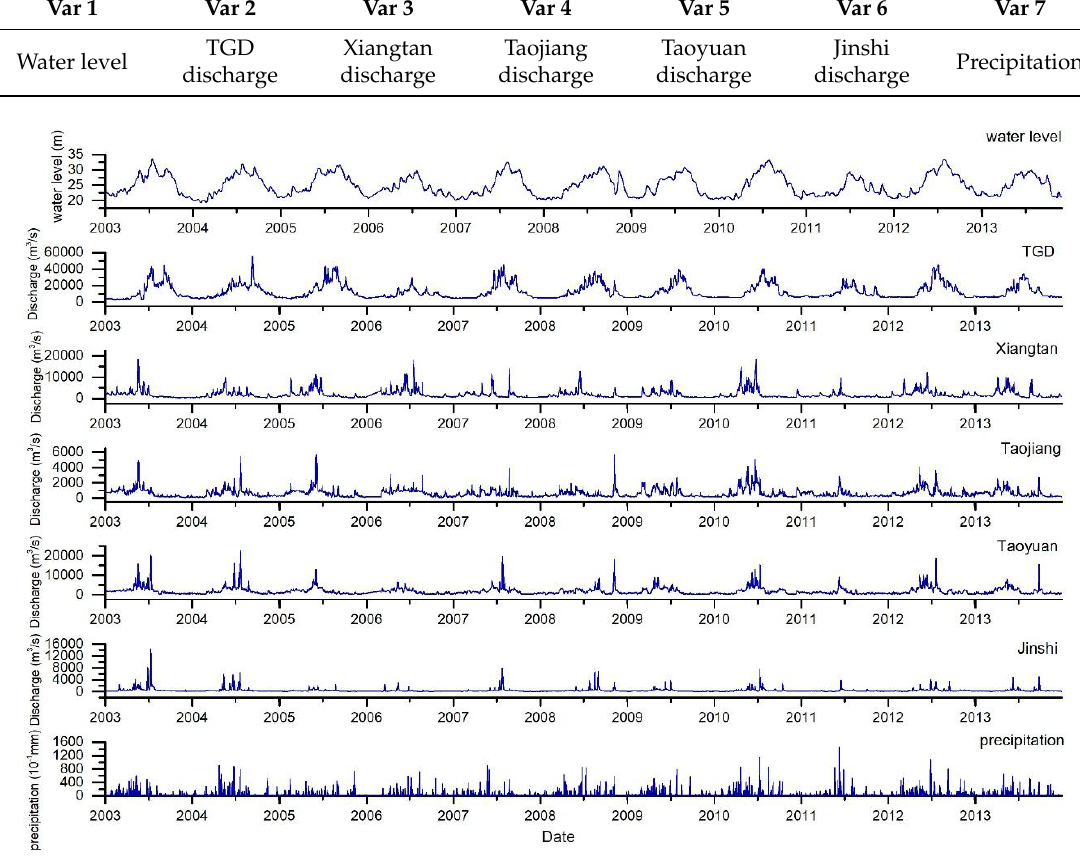
Figure 3. Data display of the selected variables.